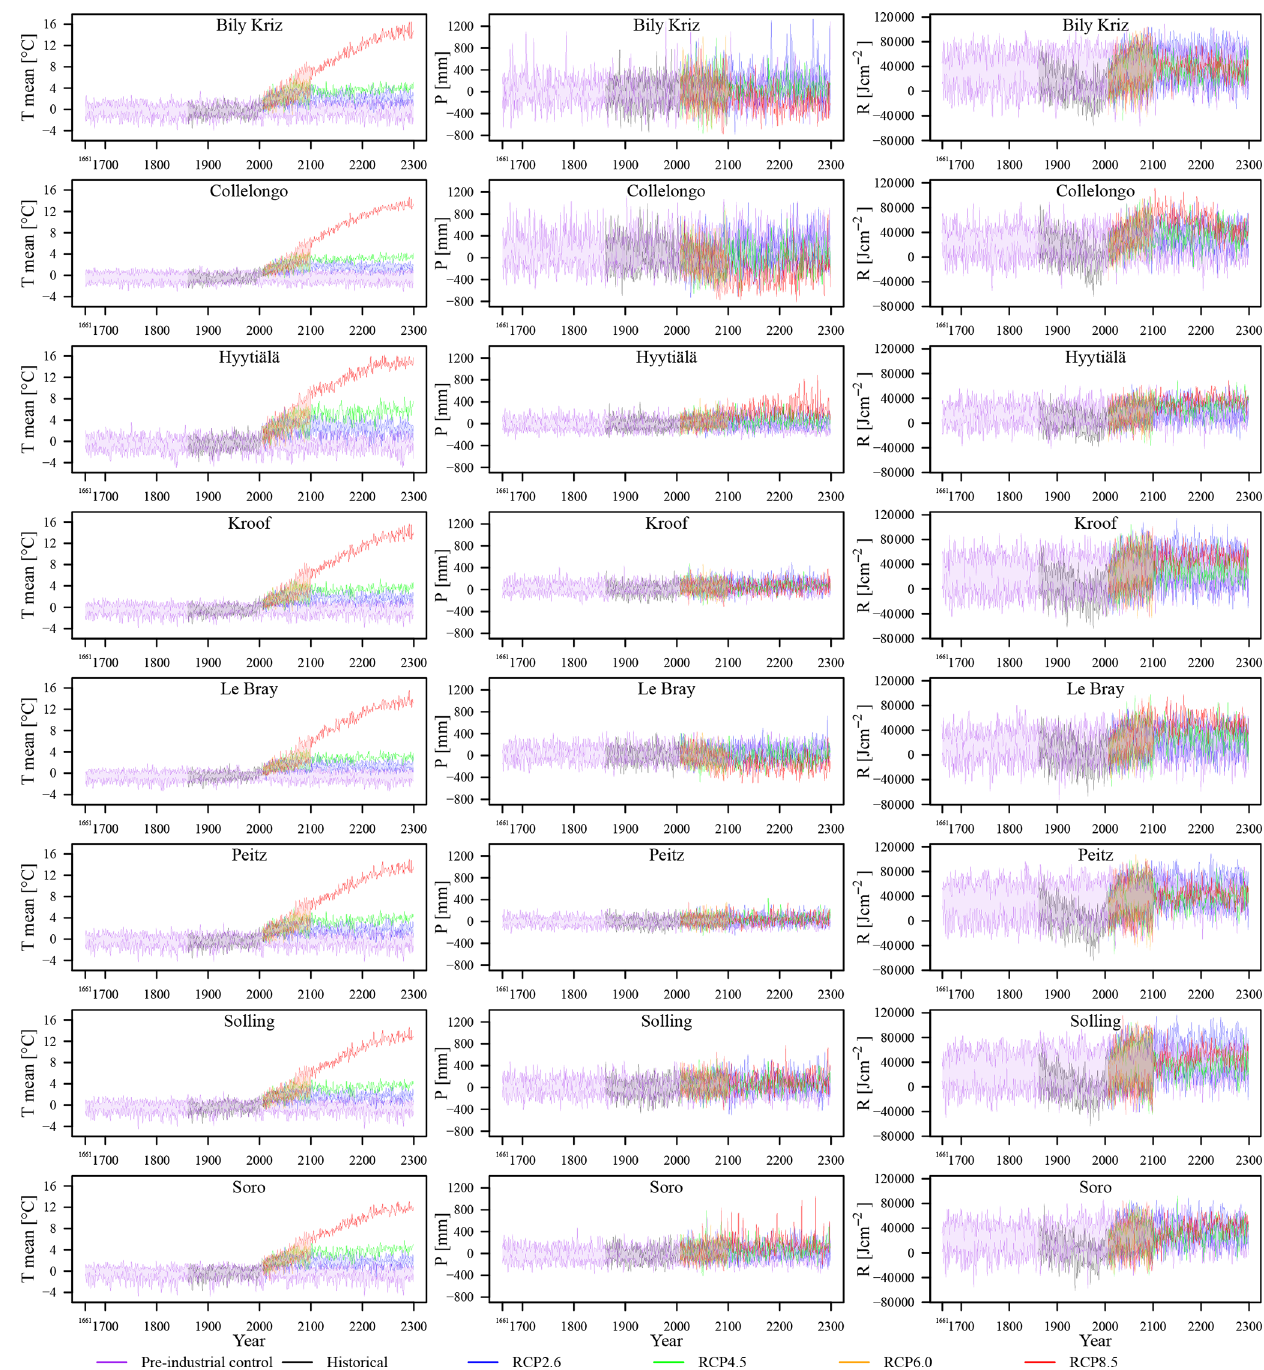
Figure 3. Change in mean annual temperature ( T mean), annual precipitation sum ( P ) and annual sum of global radiation ( R ) over the time period 1661–2299 relative to the 1980–2005 average for the ISIMIP2b locally bias-corrected (ISIMIP2bLBC) scenarios. Please note that the two Solling sites have the same